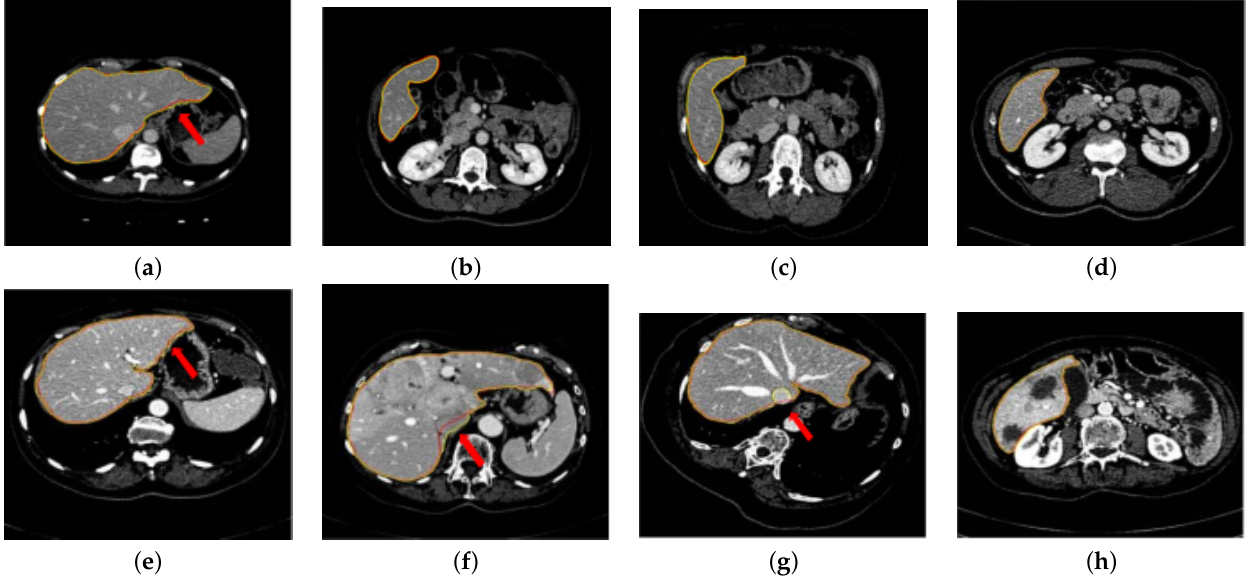
Figure 6. Representative choice of liver segmentation results by the proposed method: ( a – d ) show the images in the case of no lesions or minor lesions; ( e – h ) show the images under the condition of serious